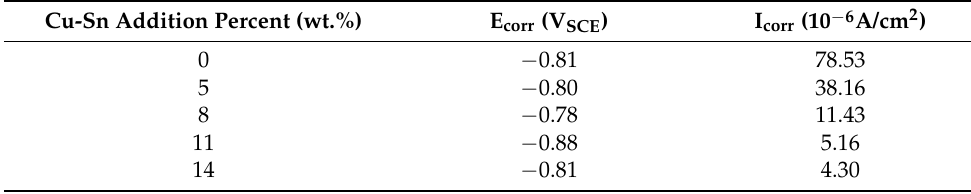
Table 2. Effect of Cu-Sn addition on corrosion potential and current of Fe-Cu-Co alloys. Cu-Sn Addition Percent